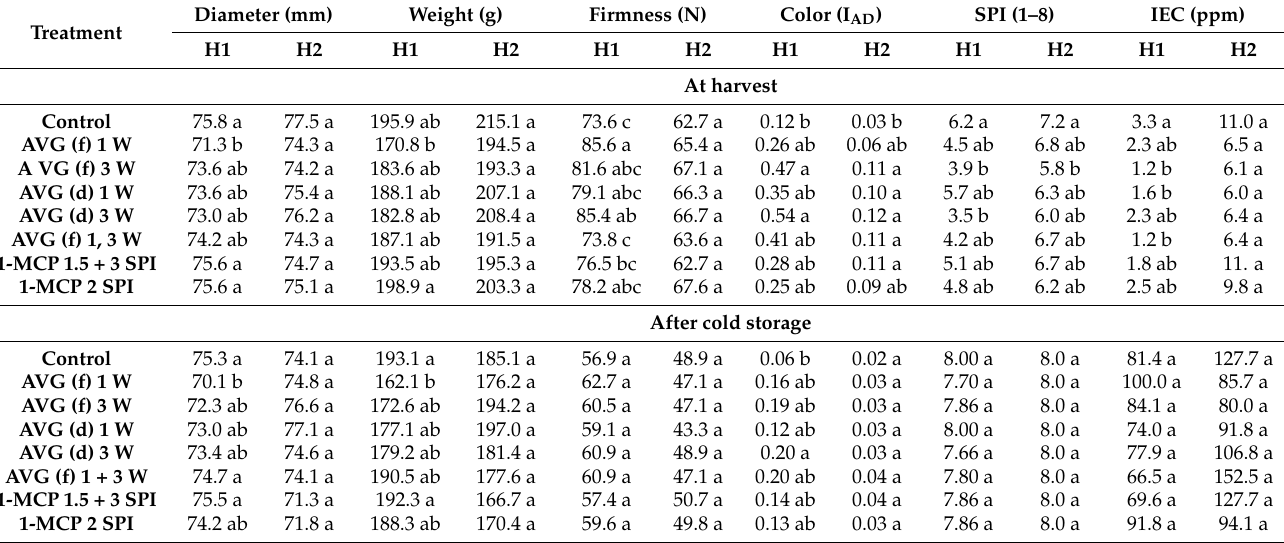
Table 2. Effects of AVG and 1-MCP on fruit quality of ‘Brookfield Gala’ apples at harvest and after cold storage, 2019, Exp.